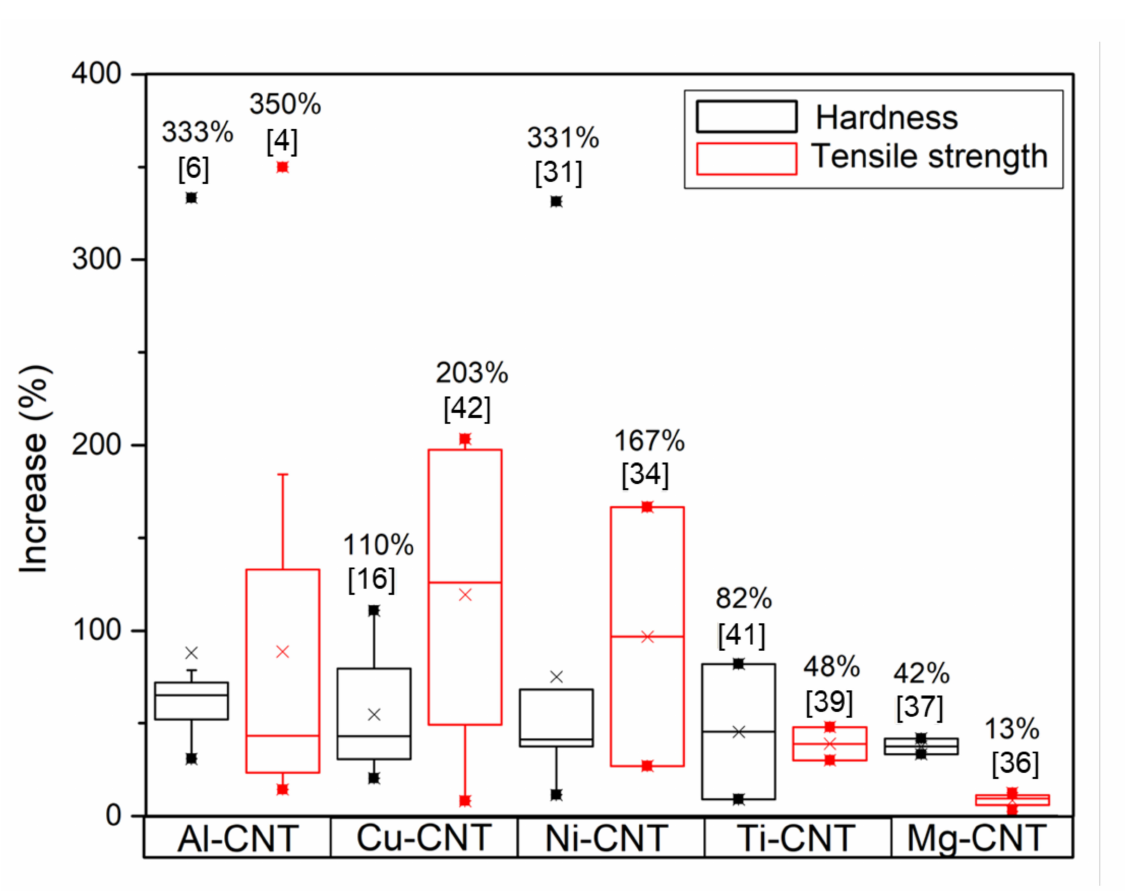
Figure 3. Increase in hardness and tensile strength, based on mechanical properties and hardness values reported in papers published in recent years (data from [1–44]), obtained for different metal matrix composites reinforced with CNTs produced by different processing and CNT dispersion